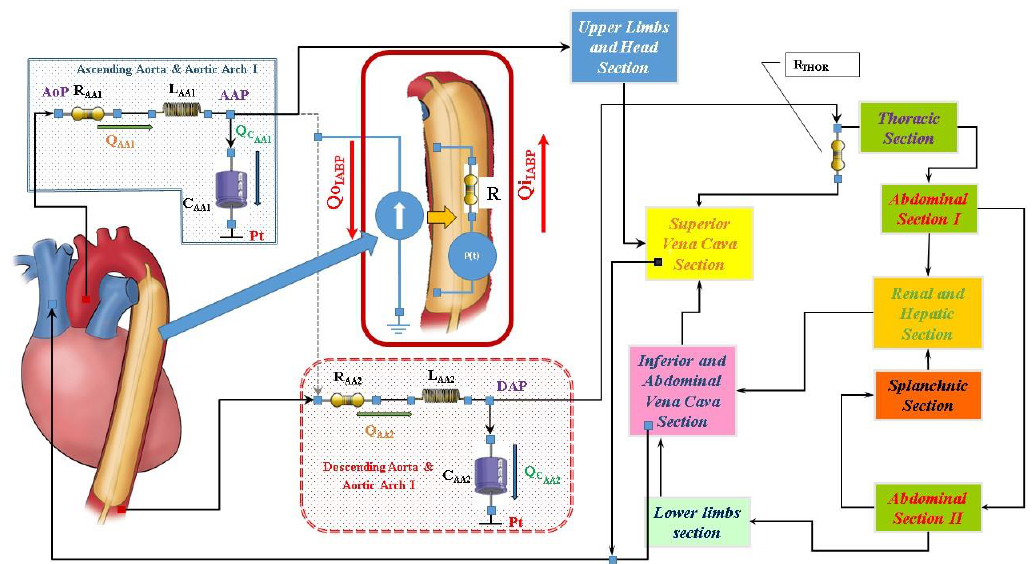
Figure 1. Schematic representation of the cardiovascular system assembled with the IABP. RLC elements in the ascending (descending) aorta and aortic arch compartment represent resistance, inductance and compliance, respectively. Pt is the intrathoracic pressure.